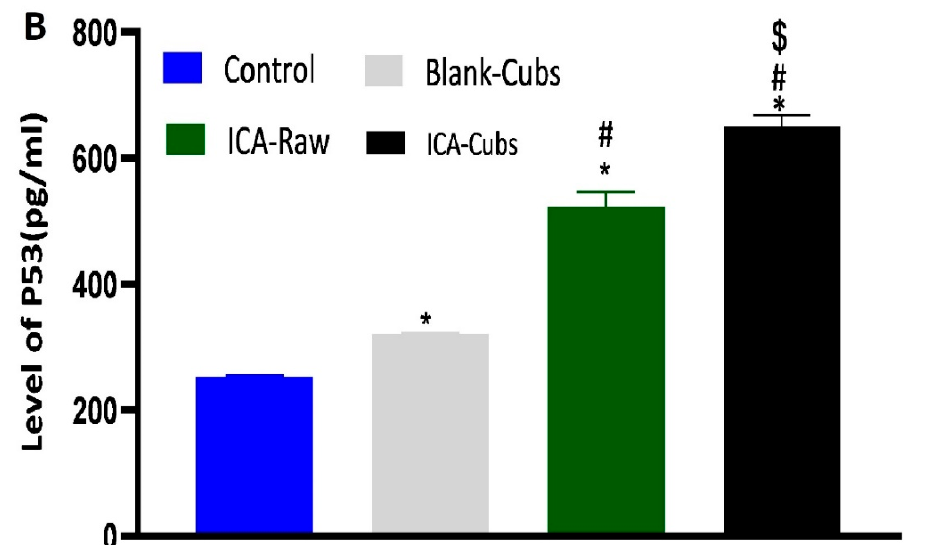
Figure 14. The expression of caspase-3 ( A ) and p53 ( B ) in SKOV-3 cells following incubation with blank-Cubs, ICA-raw, and ICA-Cubs. Data are expressed as the mean ± SD (n = 4 runs). * represents a significant difference when compared with the control ( p < 0.05), whereas # represents a significant difference when compared with the blank-Cubs ( p < 0.05) and $ represents a significant difference when compared with the ICA-raw ( p < 0.05).